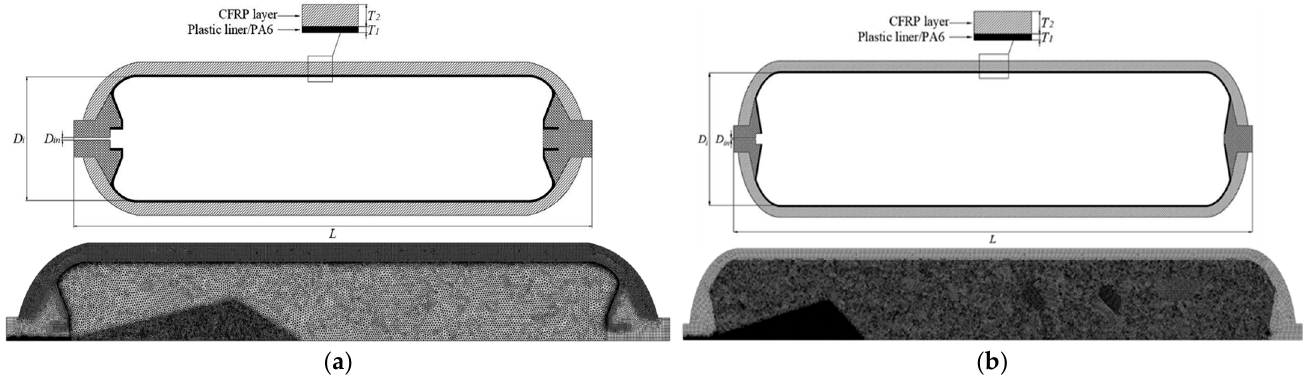
Figure 1. Geometric structure and computational grid of the considered cylinders: ( a ) Cylinder A and ( b ) Cylinder B. Table 2. Results of the gird independence check.